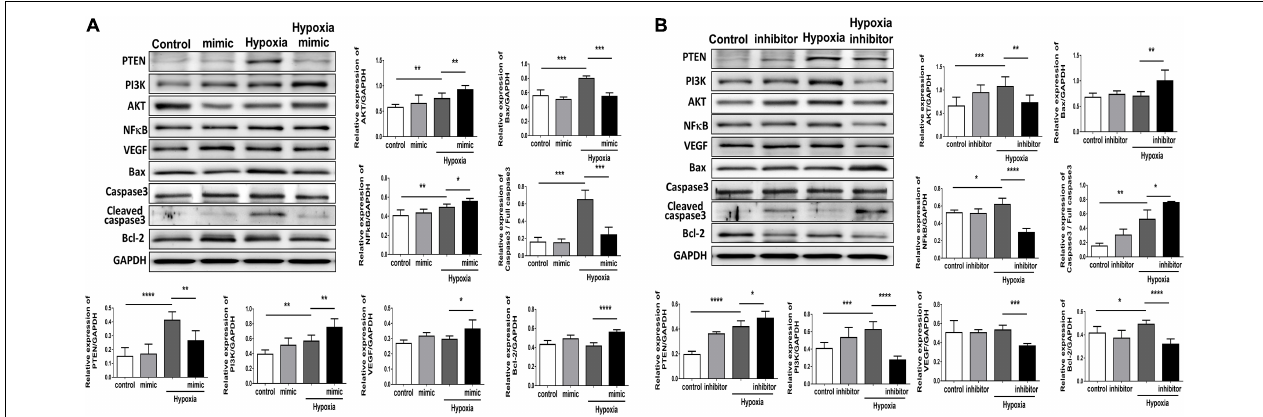
FIGURE 5 | Overexpression of miR-21 augments angiogenesis and proliferation and associated proteins but attenuates apoptosis-associated proteins in human umbilical vein endothelial cells (HUVECs) after hypoxia stimulation. Representative blots and quantification of PTEN, PI3K, AKT, NF κ B, VEGF, MMP9, and apoptosis-associated protein expression in HUVECs pretreated with (A) miR-21 mimic or (B) miR-21 inhibitor under normoxia or hypoxia for 24 h. The experiment was repeated in triplicate, * P < 0.05, ** P < 0.01, and *** P = 0.001, and **** P <